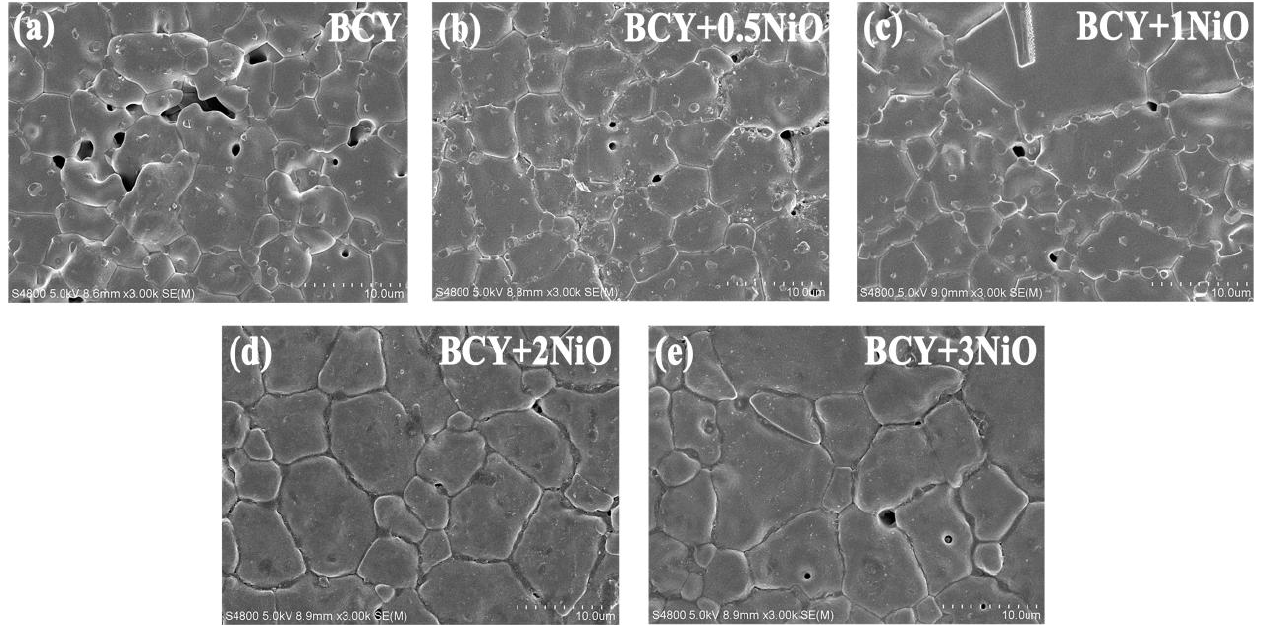
Figure 4. ( a – e ) SEM images of BCY–NiO ceramic electrolyte sheets. Figure 4. (a)-(e) SEM images of BCY–NiO ceramic electrolyte sheets. To study the effect of NiO on the electrochemical properties of the BCY electrolytes, the impedance spectra of the BCY–NiO ceramic electrolyte sheets are measured in a water- vapor atmosphere in the temperature range from 550 ◦ C to 700 ◦ C. The impedance spectra of the BCY–NiO ceramic electrolyte sheets at 650 ◦ C is shown in Figure 5. The ohmic resistances of BCY, BCY + 0.5NiO, BCY + 1NiO, BCY + 2NiO, and BCY + 3NiO ceramic electrolyte sheets are calculated to be 3.40 Ω cm 2 , 2.91 Ω cm 2 , 3.02 Ω cm 2 , 2.50 Ω cm 2, and 2.79 Ω cm 2 , respectively. The corresponding conductivities are 0.029 S cm − 1 , 0.034 S cm − 1 , 0.033 S cm − 1 , 0.04 S cm − 1, and 0.036 S cm − 1 , respectively. Arrhenius plots of the